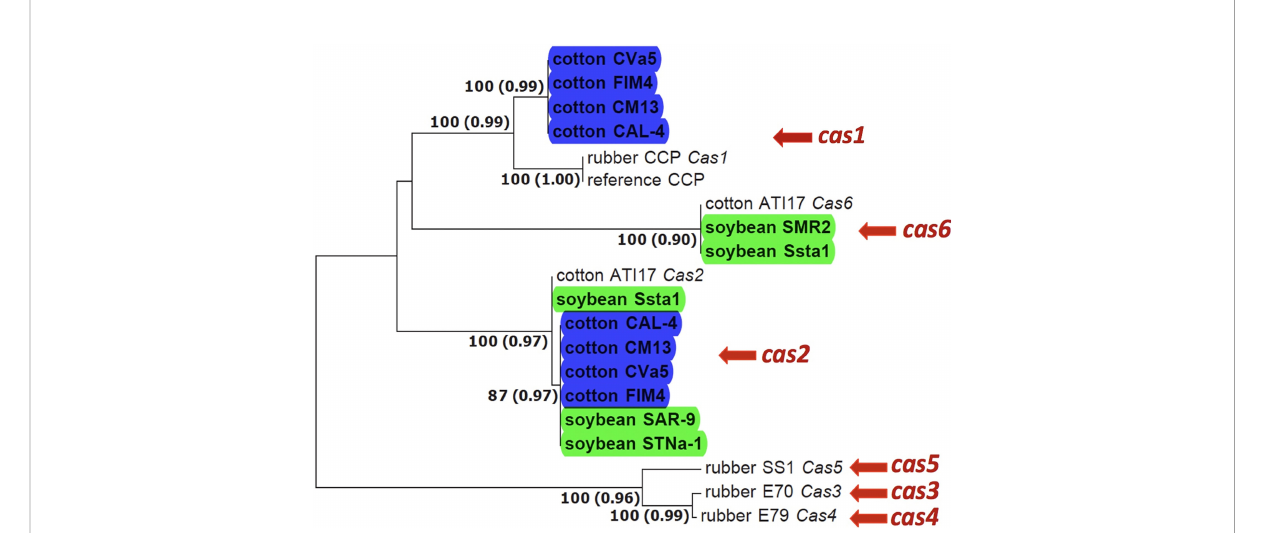
FIGURE 1 Phylogenetic tree of the cassiicolin-encoding genes in Corynespora cassiicola from different hosts and geographic regions based on Maximum Likelihood (ML) and Bayesian Inference (BI). C. cassiicola genomes sequenced and used in this study are in bold and highlighted blue (cotton) and green (soybean). ML bootstrap values > 70% are shown before the parenthesis for each of the supported branches. Posterior probabilities > 90% are shown in parenthesis. Original hosts and isolate names are indicated for all isolates. Cas7 , which is divergent from the other Cas variants, especially for nucleotide sequences, and not found in any of the genomes from this study (Lopez et al., 2018), is not included.